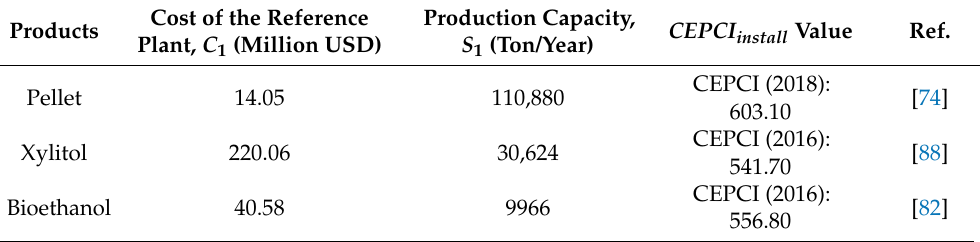
Table 3. Total capital investment of individual pellet, xylitol, and bioethanol production plant.